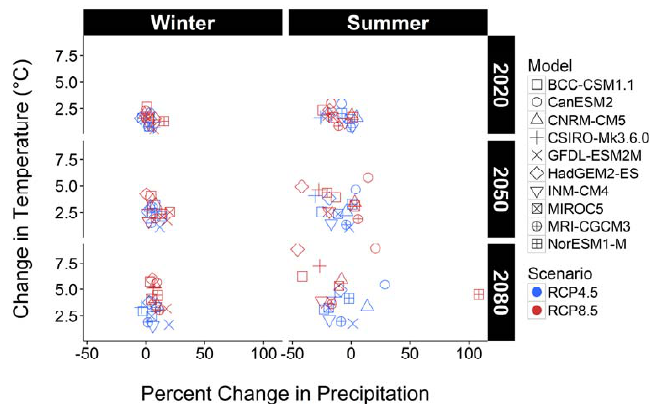
Figure 3. Change of temperature and annual percent change in precipitation in comparison to historical conditions for all GCMs.